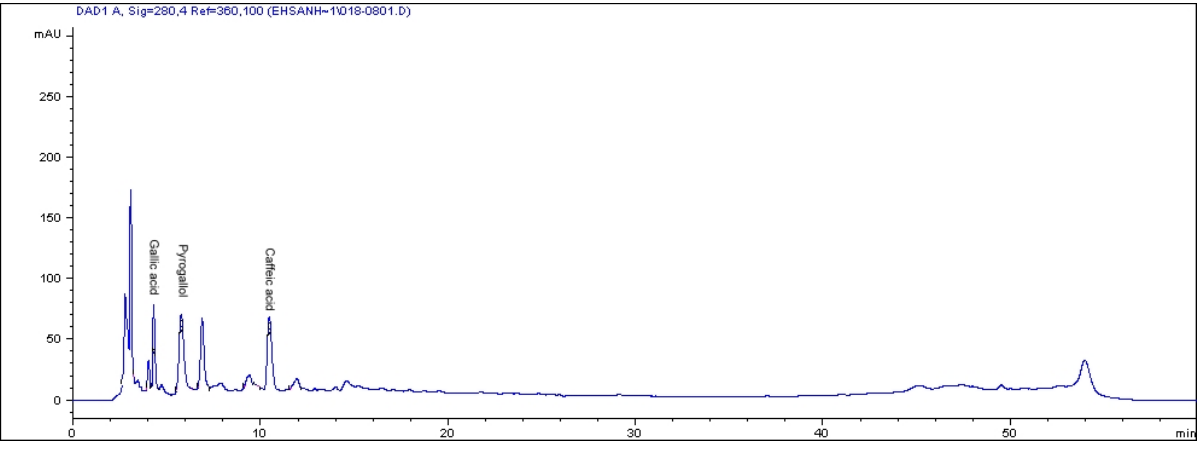
Table 3. Total saponin content (mg diosgenin equivalent/g DM) in the leaf, stem and root from three varieties of Labisia pumila.